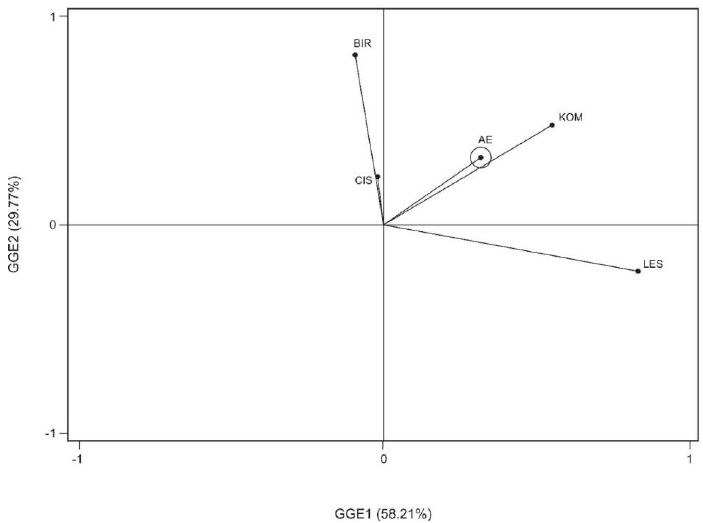
Figure 4. View of average environment coordination (AEC) on the GGE-type biplot based on principal components of the environments. AE in the circle is the “average environment” for BIR, CIS, KOM, and LES designated for the comparison. BIR—Bircza, CIS—Cisna, KOM—Koma´ncza, LES—Lesko experimental